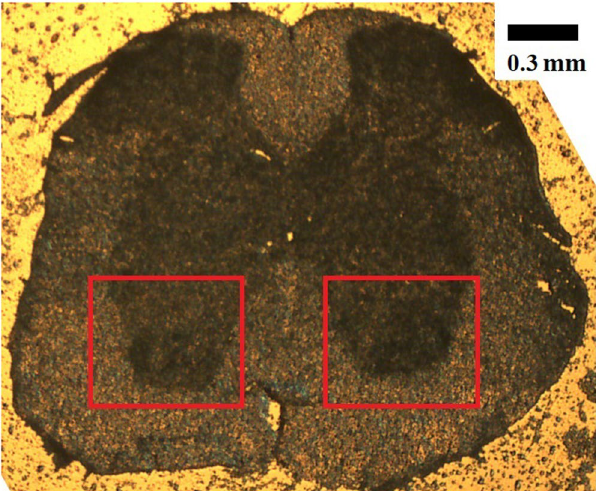
Figure 1. Representative microphotograph (5X objective) of a mouse spinal cord tissue section in the lumbar tract (L1-L2). The dorsal half section is up; the ventral half is down. The scale bar is 0.3 mm. The red boxes indicate the area of the ventral horn (where the cell bodies of the motor neurons reside) that were